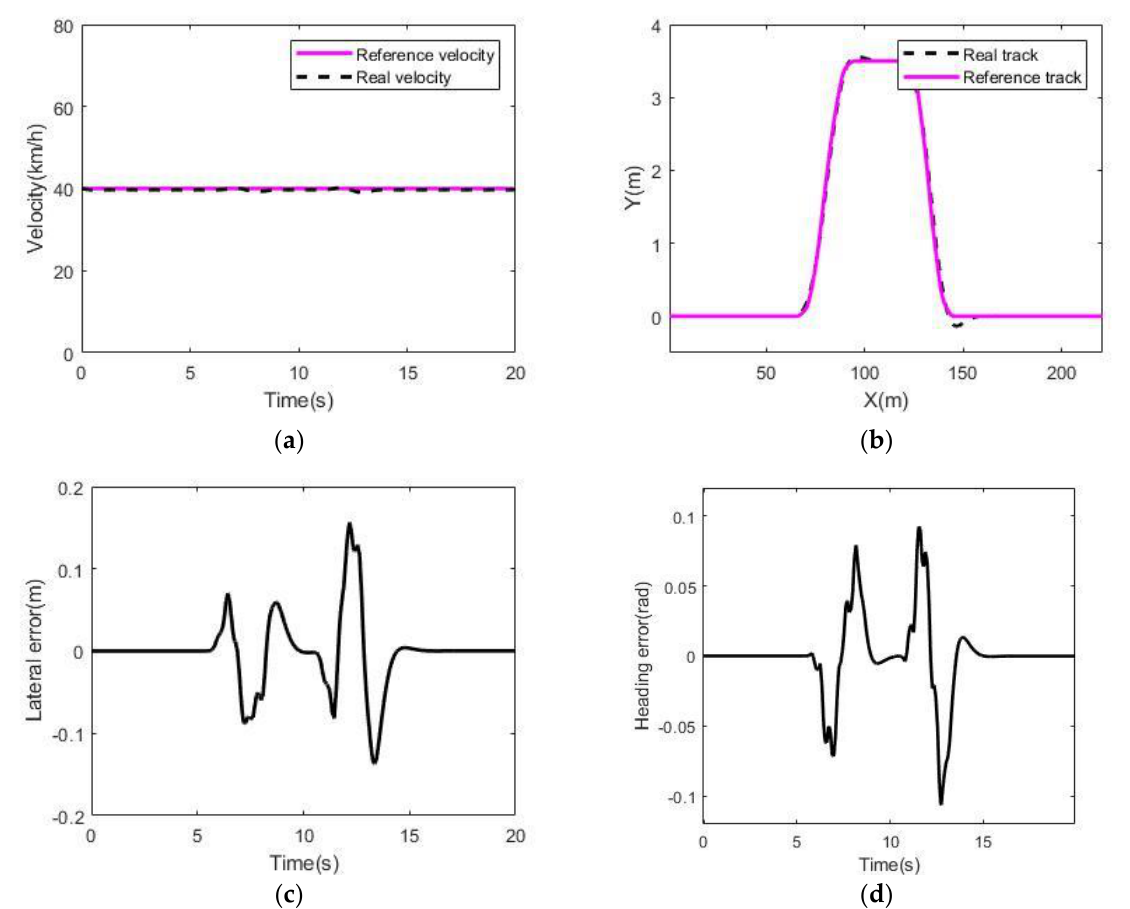
Figure 7. Vehicle state and tracking error: ( a ) velocity; ( b ) vehicle location; ( c ) lateral error; ( d ) heading error.